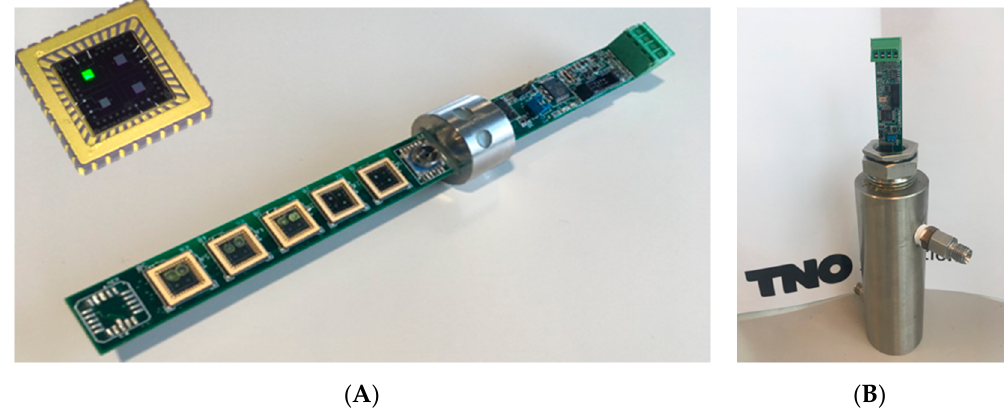
Figure 3. ( A ) Sensor array Printed Circuit Board (PCB) including five coated sensing chips, having ten functional electrodes, and five AD7746 chips. ( B ) Sensor array in gas cell for exposure to gas